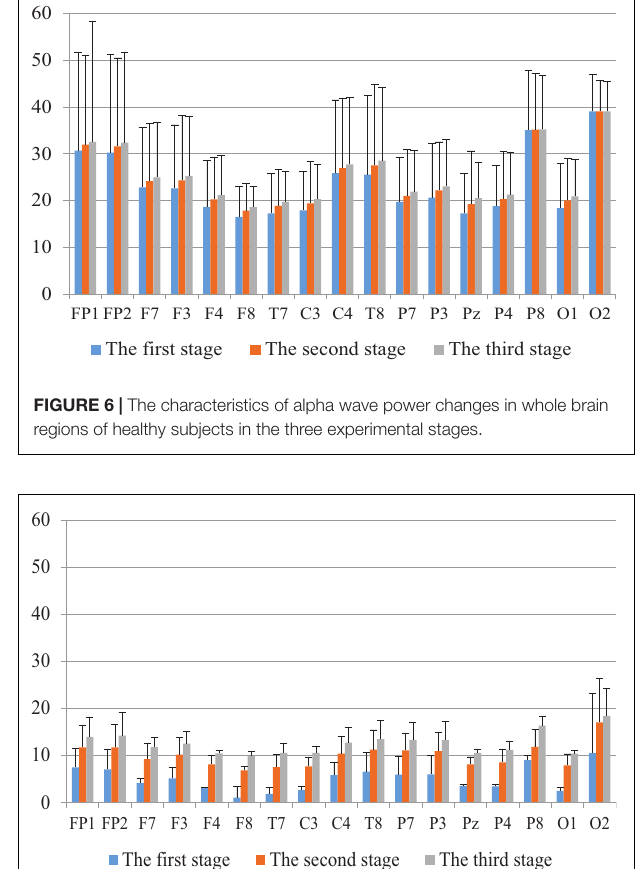
freedom within group is 339. P = 4.55 × 10 − 15 0.05, indicating a significant difference between groups. In condition × hemispheric interaction effect, it is divided into hemispheres (left and